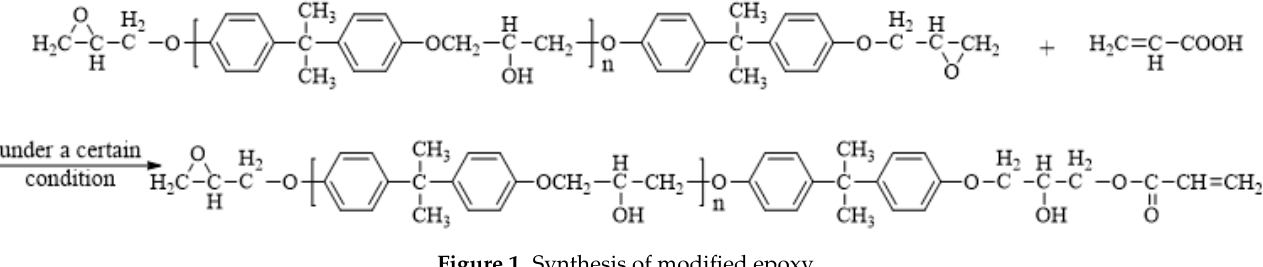
Figure 1. Synthesis of modified epoxy.